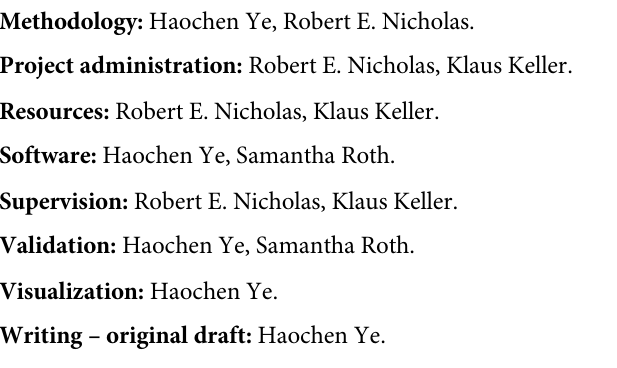
(blue circles) are close to the hindcasts of the updated model (red line) and the observations (black dots).